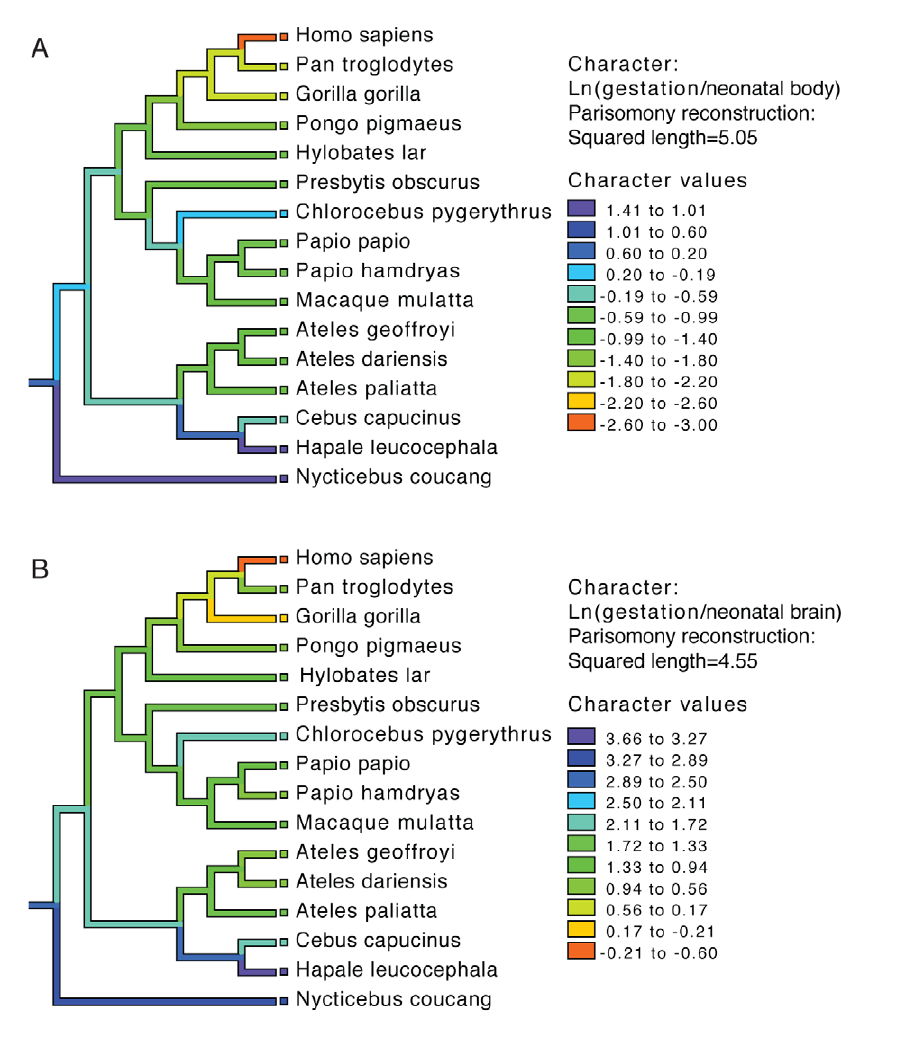
Figure 2. Phylogenetic analysis of brain size, body size, and gestational length in primates. Gestational time to neonatal brain (A) and neonatal body size (B) natural logarithm-transformed ratios are shown for each species and color coded along each lineage as inferred by parsimony. Allometric data was acquired by Sacher and Staffeldt (1974) [15] and phylogeny by Purvis [41].